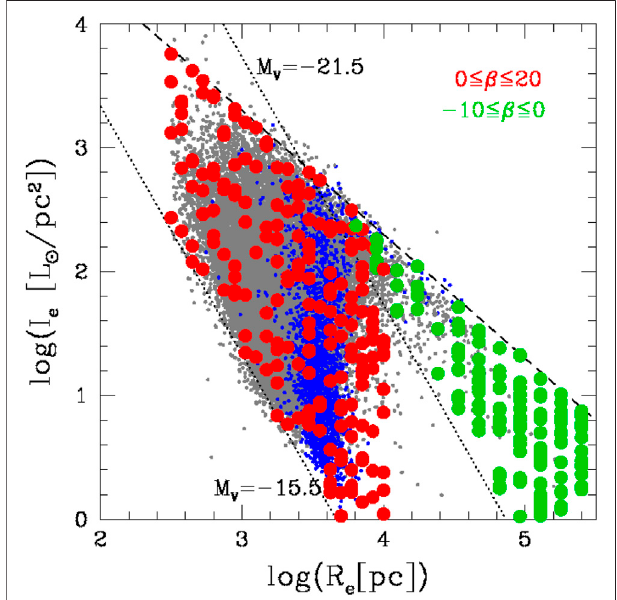
FIGURE 2 | The KR plane. The gray dots mark the observational data of the WINGS survey. The red and green dots mark the values of I e and R e obtained starting from Eq. 1 [see D ’ Onofrio and Chiosi, 2020] using different values of β . The dashed line represents the ZoE. The dotted lines the locus of constant luminosity, respectively at M V (cid:1) − 21.5 and M V (cid:1) −